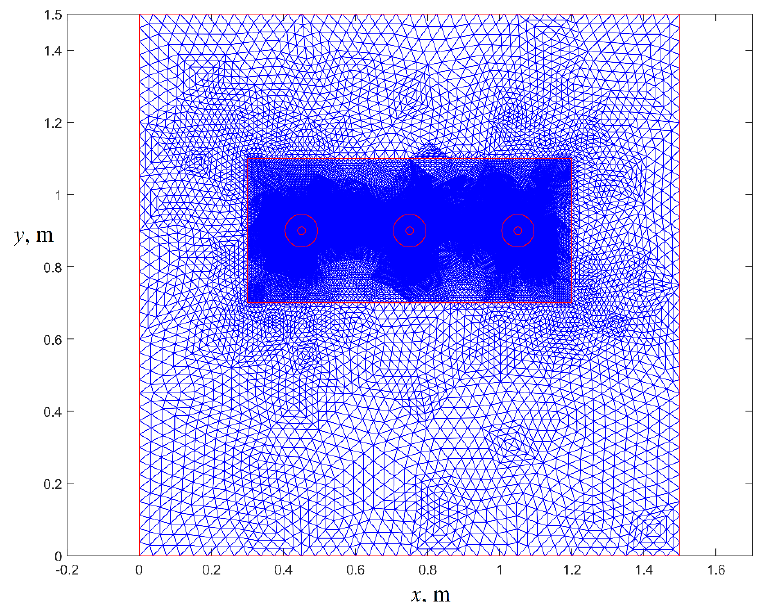
Figure 7. A numerical grid used in the computations.